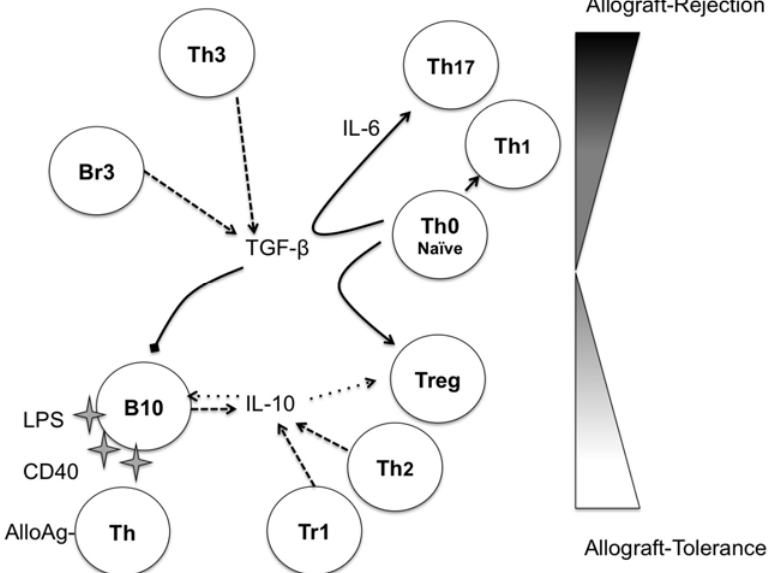
Figure 1. Potential immunoregulatory network in transplantation: IL-10 and transforming growth factor (TGF)- β are the soluble key players in the immunoregulatory network. IL-10 can be secreted after B10 stimulation by Lipopolysaccharide (LPS), CD40 and alloantigen- specific T-cells early in the alloimmune response. IL-10 then evokes a positive loop, activating B10 cells and favoring the maintenance of regulatory T-cells (Tregs), providing an allograft-tolerance environment. TGF- β could drive the generation of Treg cells from naive T-cells, but in the presence of IL-6 in the local milieu, TGF- β skews the differentiation of naive T-cells to Th17 cells with a potential detrimental role for the allograft. Moreover, TGF- β can induce apoptosis in B10 cells, thus blocking the positive loop to tolerance induction. Abbreviations: B10, IL-10 producing-regulatory B-cells; Th, T-helper cells; Tr1, Type 1 regulatory T-cells; Tregs, regulatory T-cells. Arrows: Black, differentiation; striped, production; dotted, positive effect; truncated, negative